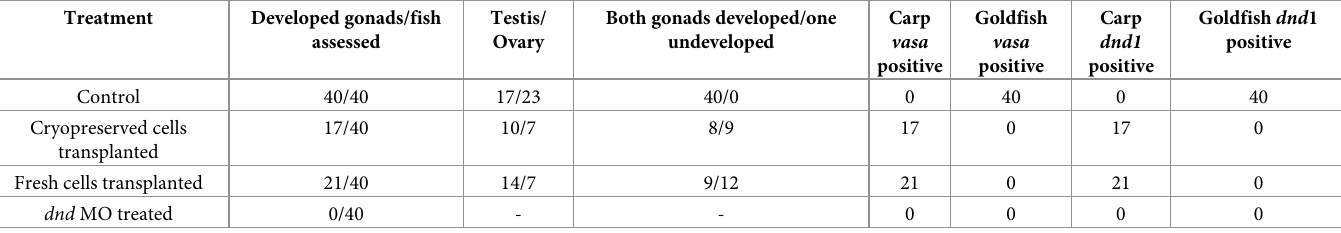
Table 3. Summarized results of transplantation success and carp vasa and dnd1 RNA expression in germline chimeras evaluated 3 months post-transplantation.